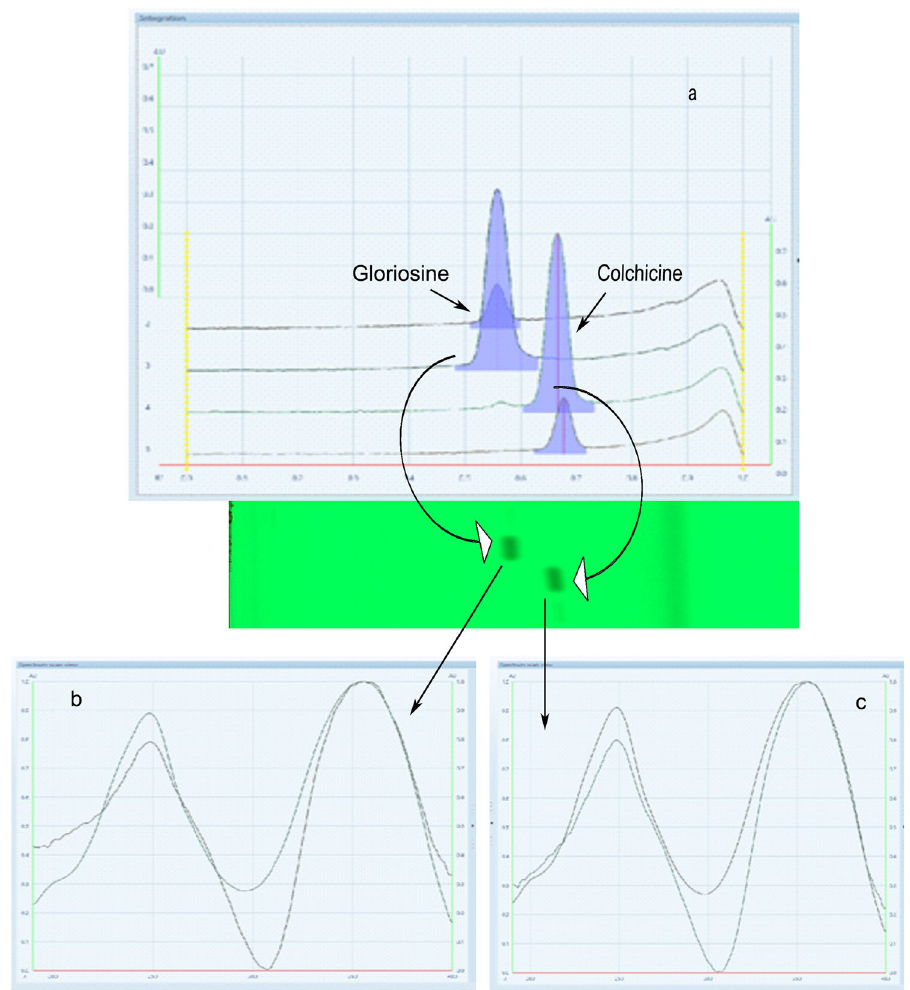
Figure 2. HPTLC quantification of targeted metabolites. The colchicine and gloriosine markers were isolated through preparative TLC and purity of isolated colchicine (Iso1) and gloriosine (Iso2) were estimated using validated HPTLC method. ( a ) Overlay spectra and chromatogram of standard colchicine and gloriosine with Iso 1 and Iso 2. ( b ) Comparison of absorption spectra of reference gloriosine and Iso 2 and ( c ) Absorption spectra of reference colchicine and Iso 1 in the UV–Vis range of 200 to 800